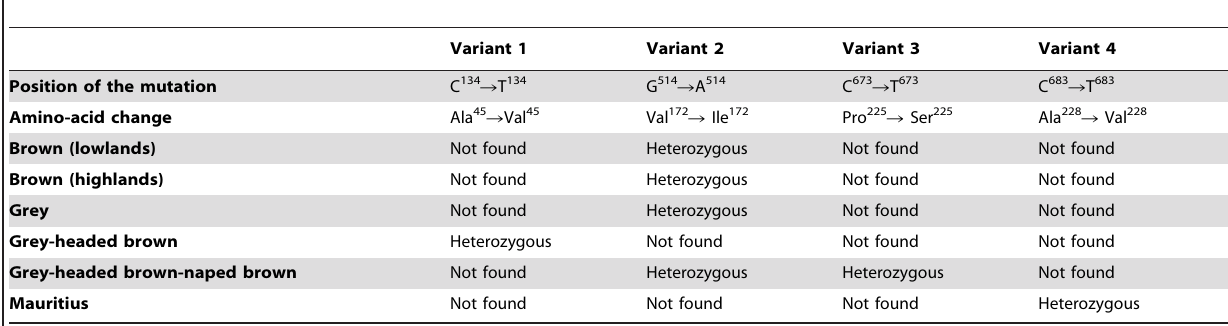
Table 3. Amino-acids variants observed at the MC1R locus in 51 Z. borbonicus individuals representing the four Re´union morphs and nine Z. mauritianus